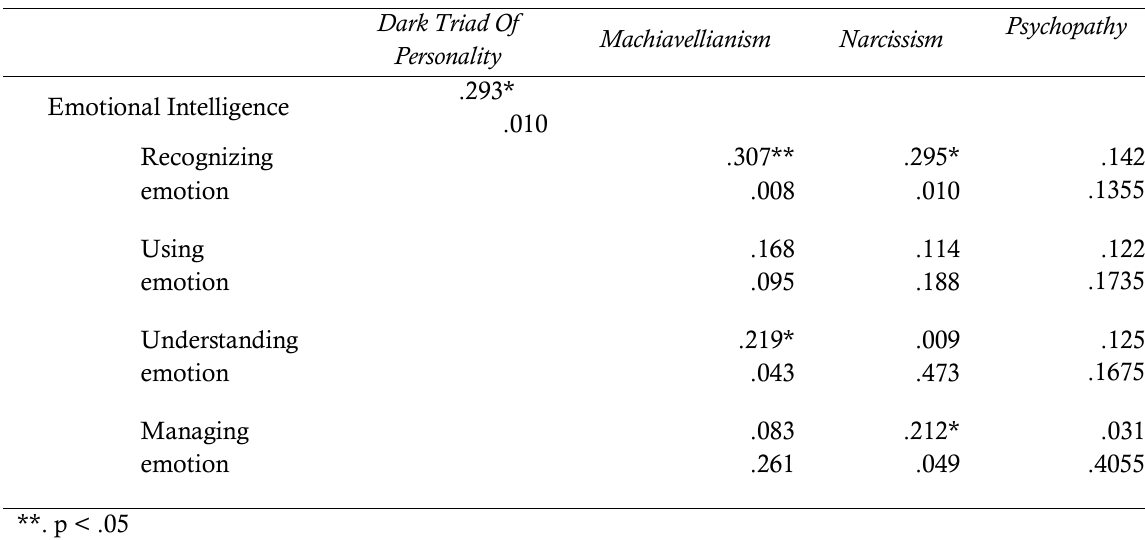
Correlation Test Results of Product Moment